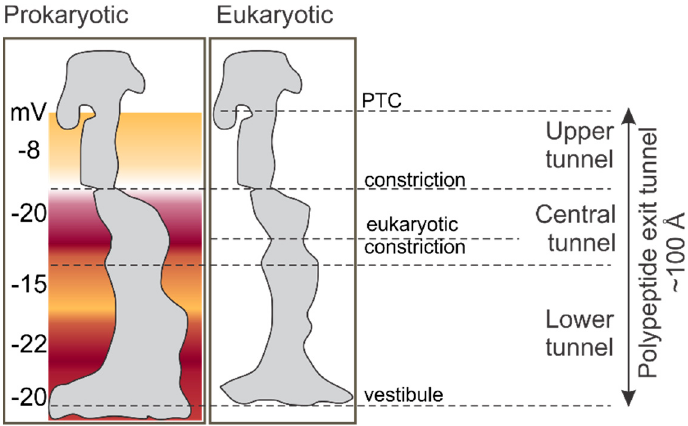
Figure 2. Dimensions of the peptide exit tunnel in ribosomes from prokaryotic and eukaryotic origin [34,38]. Color visualizes the electrostatic potential within the tunnel.